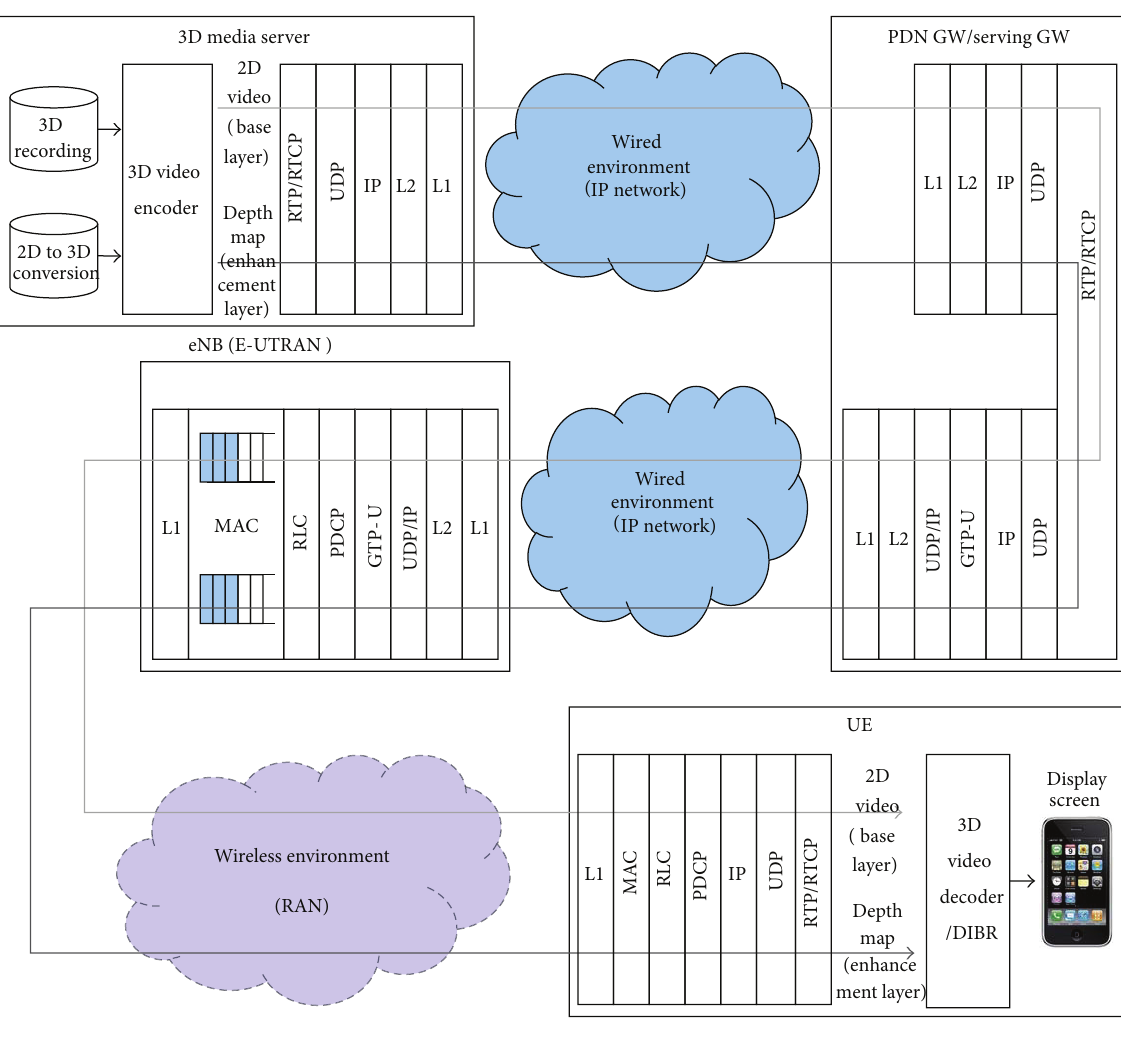
Figure 1: System architecture of 3D A/V over wireless systems.